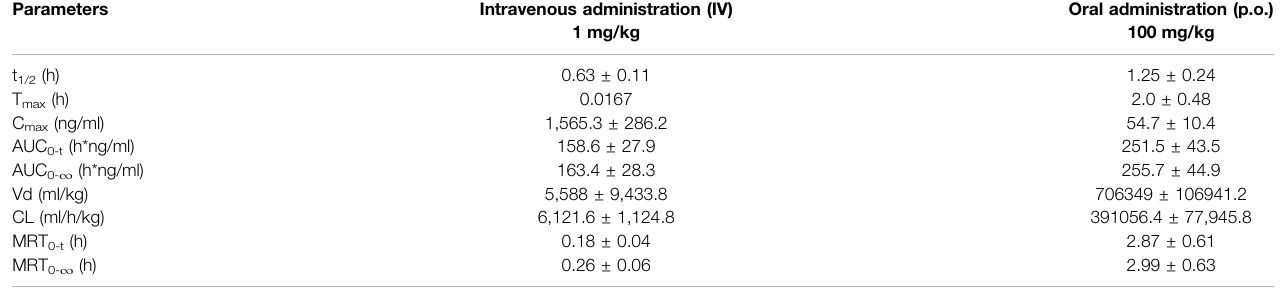
TABLE 4 | Main pharmacokinetic parameters of Indo5 following intravenous or oral administration. Parameters